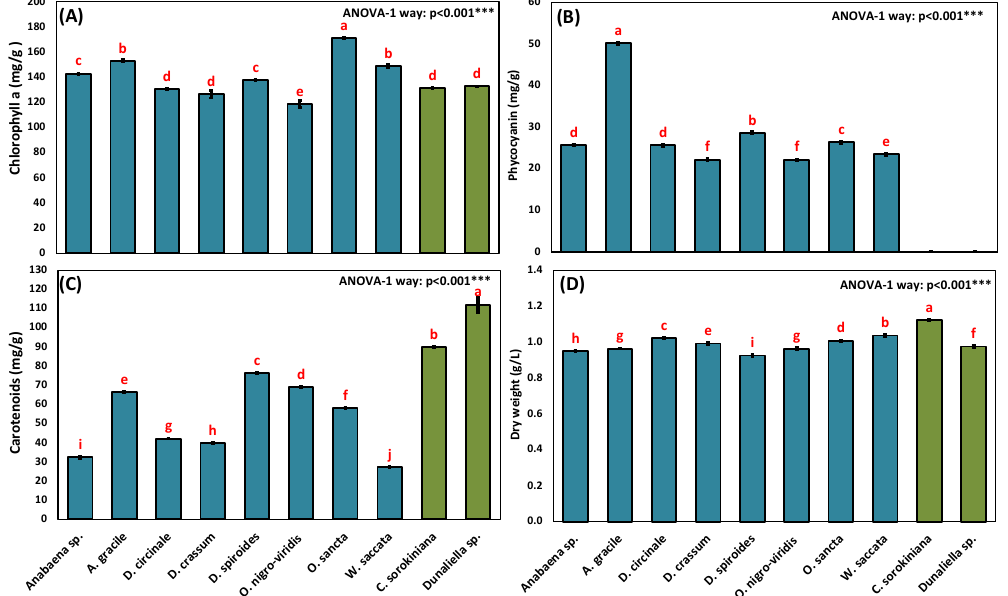
Figure 1. ( A ) Chlorophyll-a, ( B ) phycocyanin, ( C ) carotenoids, and ( D ) dry weight of the different cyanobacterial and algal strains. Bars with different superscript letters were significantly different according to DMRT at the p < 0.05 level. ***: Significant at p < 0.001. The dry weight of the 10 studied cyanobacteria and microalgae showed its lowest average of 0.93 ± 0.002 in D. spiroides and its highest value ( ± SE) of 1.12 ± 0.001 g/L in C. sorokiniana , with a highly significant difference in dry weight between studied the cyanobacteria and algal species (Figure